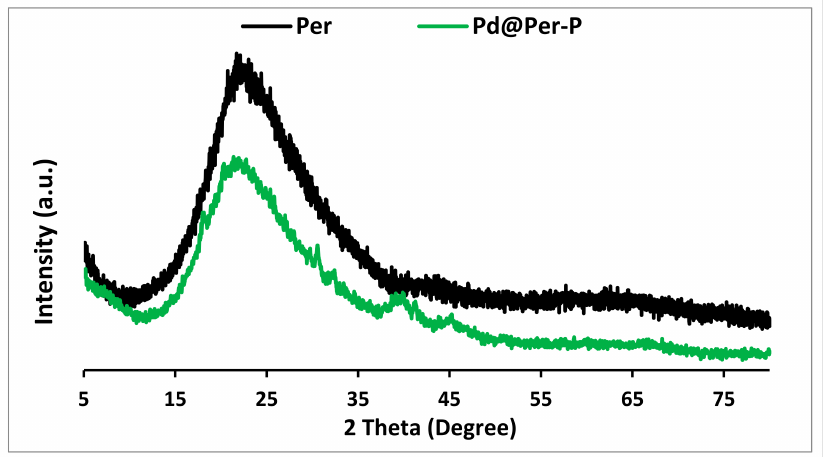
Figure 6. Comparison of the XRD patterns of Per and